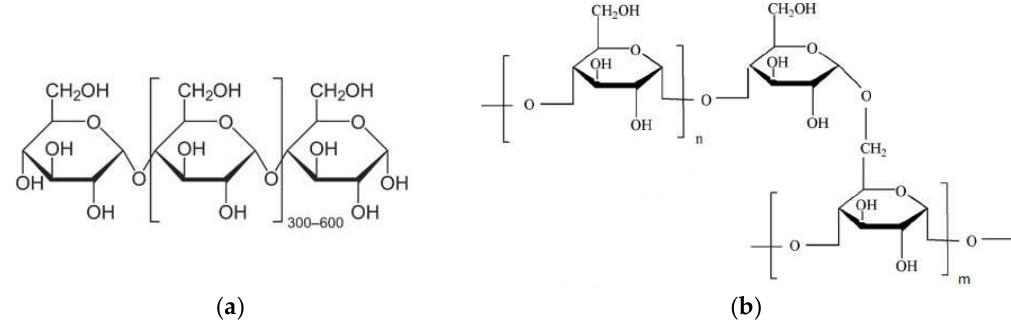
Figure 5. Structure of ( a ) amylose and ( b ) amylopectin.